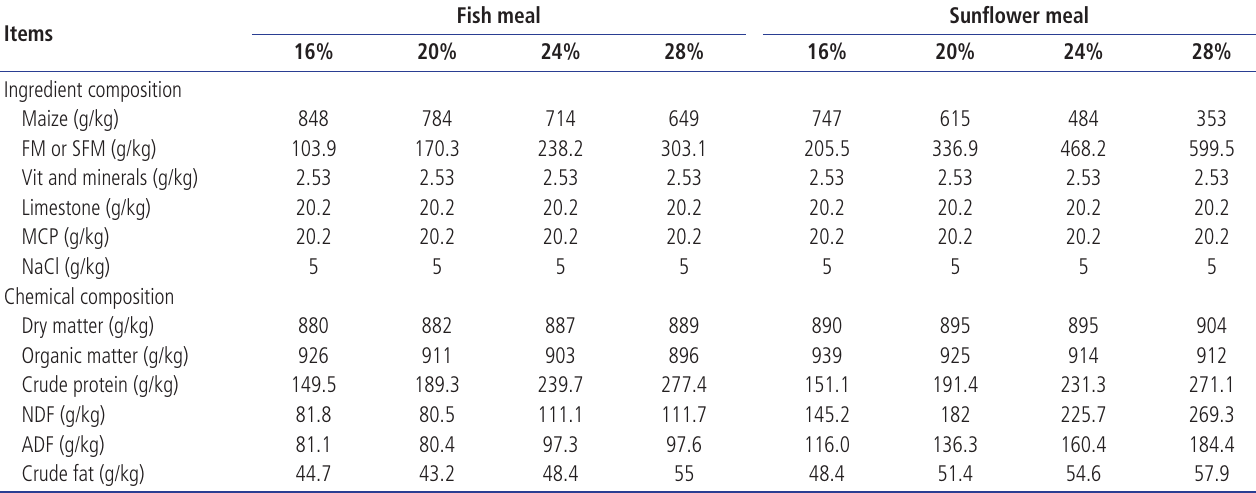
Fish meal Sunflower meal